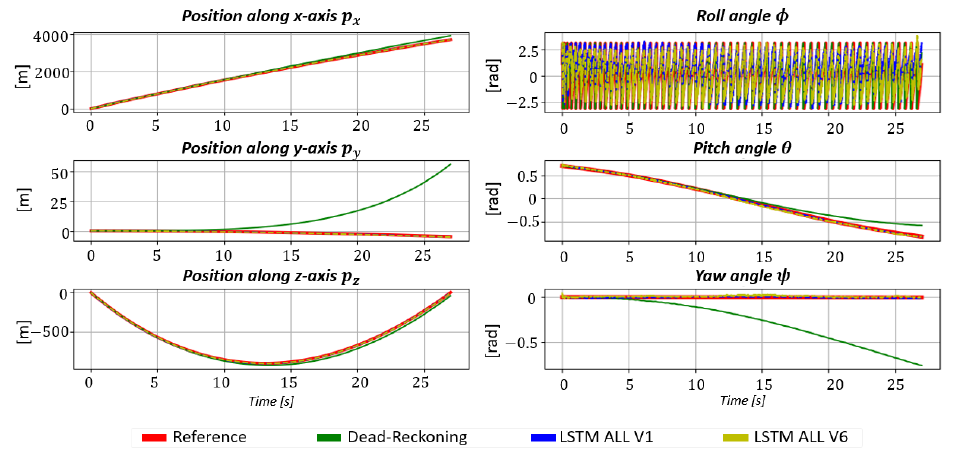
Figure 5. Estimated projectile position [m] and Euler angles [rad] obtained by the Dead-Reckoning (green), LSTM ALL , V (blue), LSTM ALL , V (yellow) and the reference 6 1